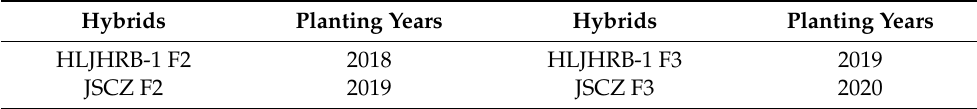
Table 5. Seed collection and planting time of tested